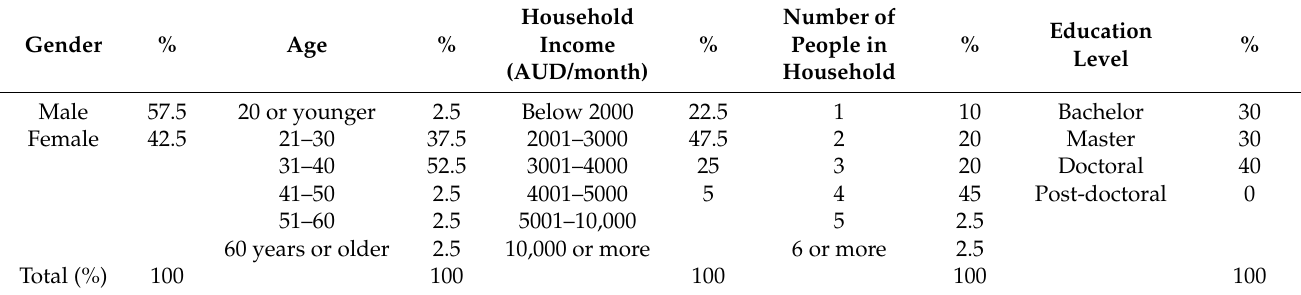
Table 3. General demographic profiles of the Indonesian consumers evaluating goat ‘bakso’ meatballs made with varying levels of rice bran substituted for